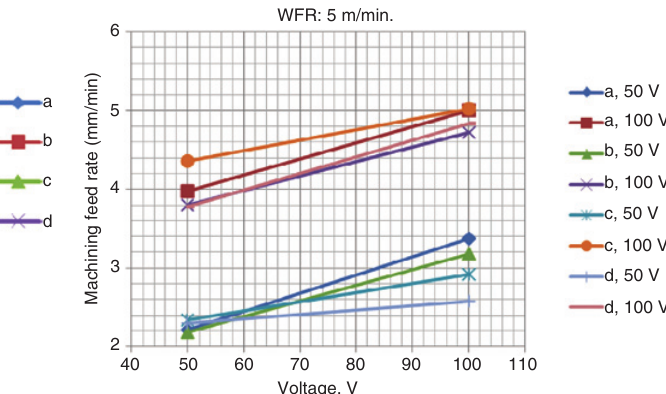
Figure 10 Machine feed rate: